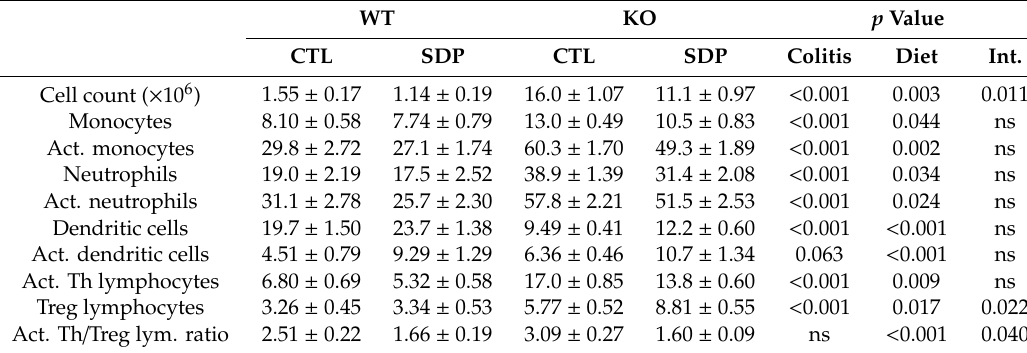
Table 2. E ff ects of SDP Supplementation on The Immune Populations of The Lamina Propria of The Colonic Mucosa of Mdr1a KO